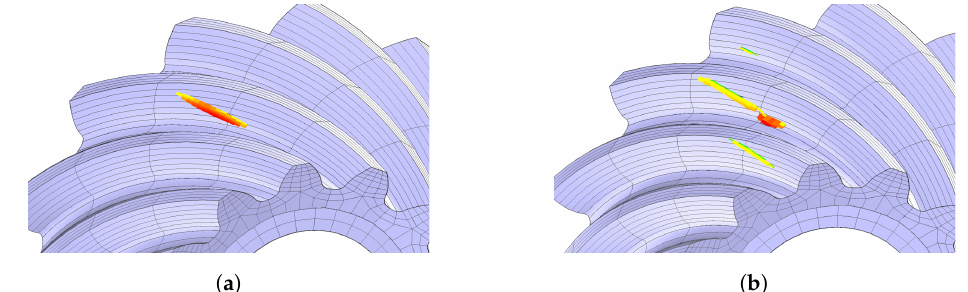
Figure 16. Instantaneous contact area(s) at the same meshing configuration on the pinion before and after wear simulation (performed updating the geometry every 5 Mc). ( a ) Before wear. ( b ) After wear.